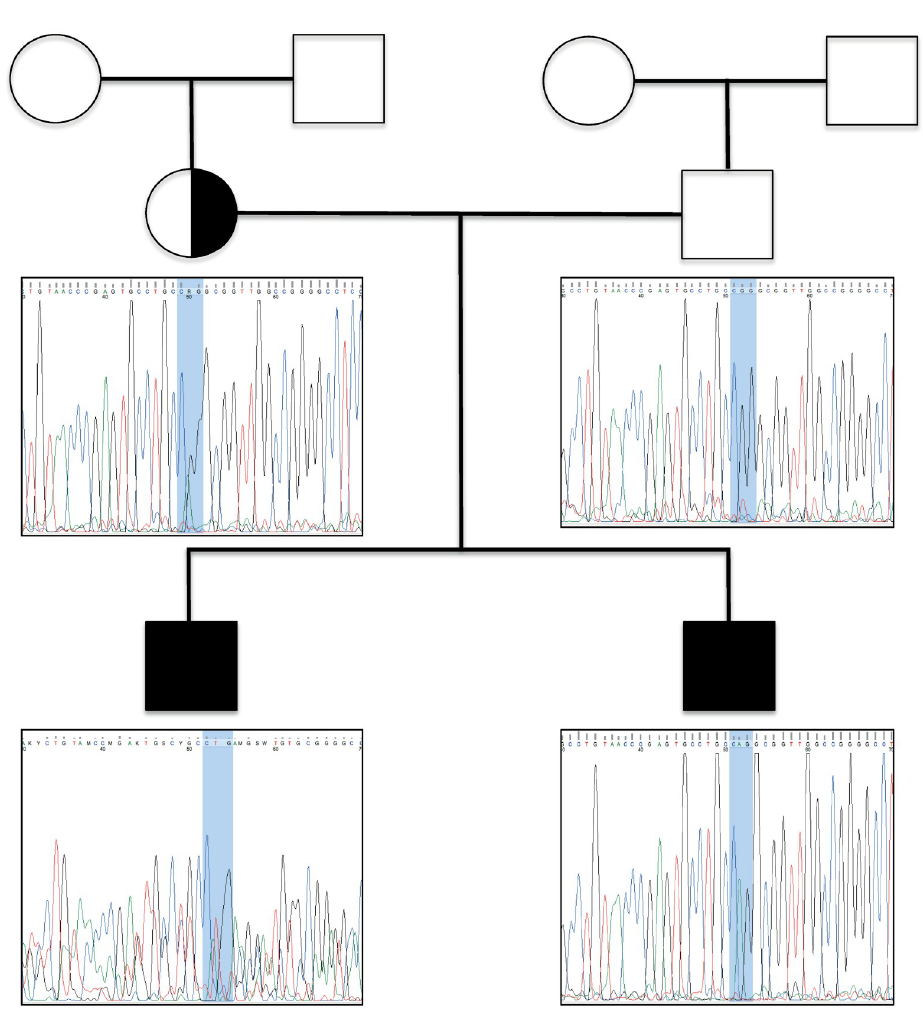
Fig 2. Pedigree and electropherograms of a non-consanguineous Turkish family segregating X-linked dominant periventricular nodular heterotopia. Two hemizygous brothers carry the novel c.1451G > A (p.Arg484Gln) variant. Asymptomatic mother is a heterozygous carrier of the variant. Father carries the reference allele.